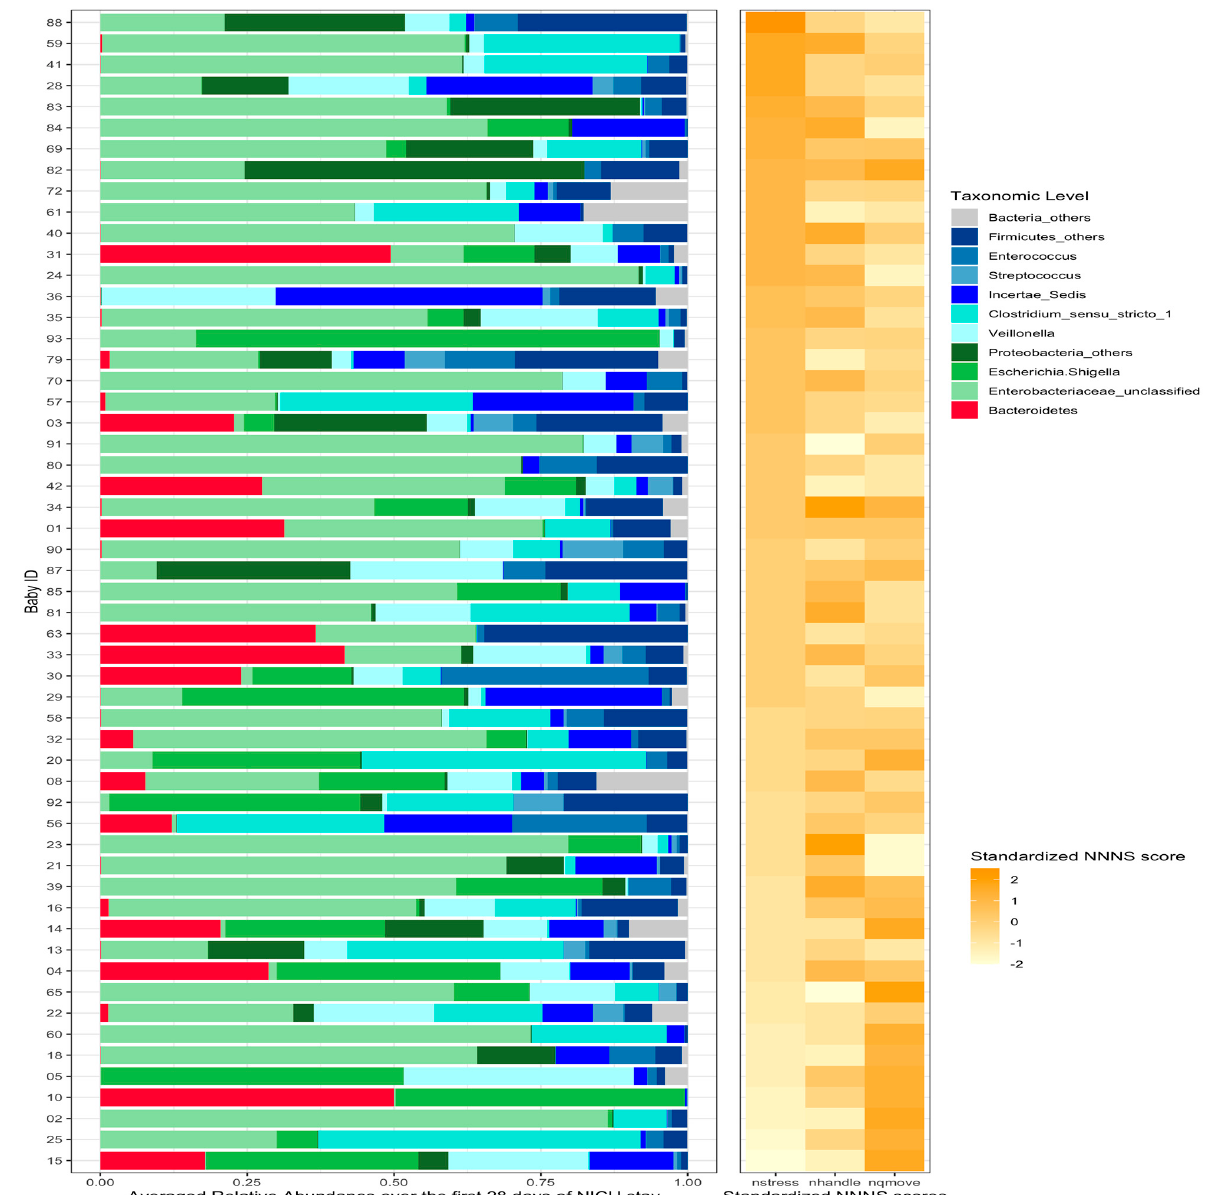
Figure 1. Relative abundance of gut microbiota and 3 sub-scales for each infant. ( a ) Relative abun- dance of gut microbiota for each infant. ( b ) Standardized scores of NNNS subscales for each infant. The infants were ordered according to the standardized score of NSTRESS scores. A standardized score of NNNS subscales (NSTRESS, NQMOVE, and NHANDLING) was generated by dividing the di ff erence between each infant’s score and the mean by the standard deviation. The standardized scores of each of these subscales were plo tt ed with the gut microbiome for each infant.